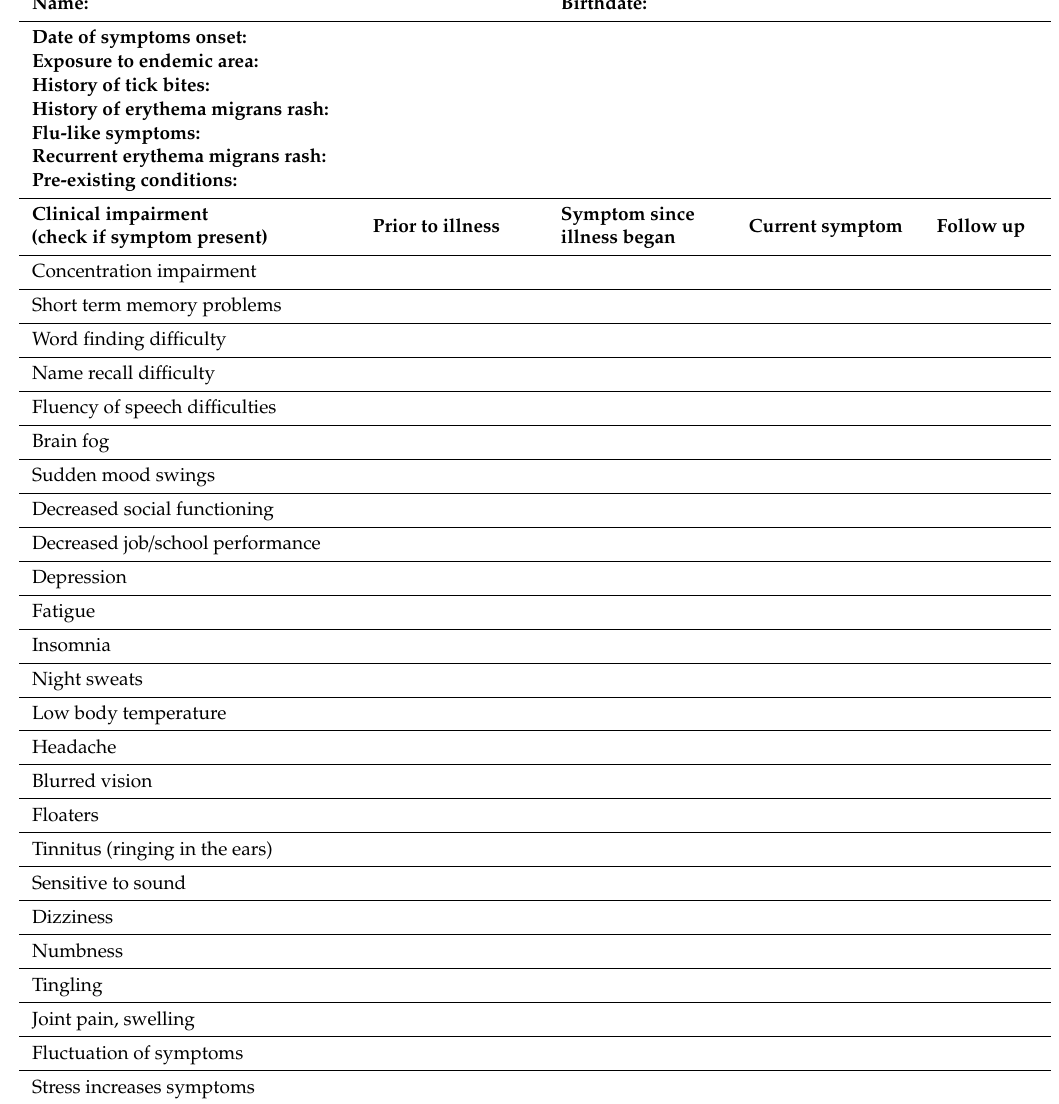
Table 6. Reduced set of 24 highly significant impairments. Suitable for pre-evaluation by